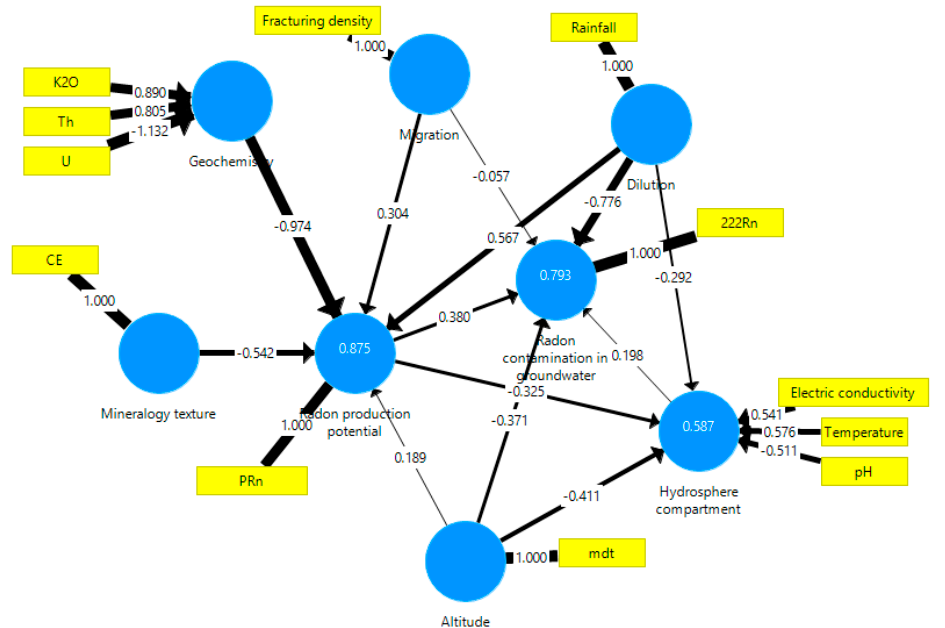
Figure 8. Diagrammatic representation of PLS-PM complete models for cluster C1 composed mainly by metasediments. The circles represent the latent variables, and the rectangles are the formation variables (see description in Table 1), the arrows characterize the links between the formation and associated latent variable, as well as among related latent variables, while arrow labels are weights and path coefficients that quantify those links. Please consult the caption of Figure 4 for additional